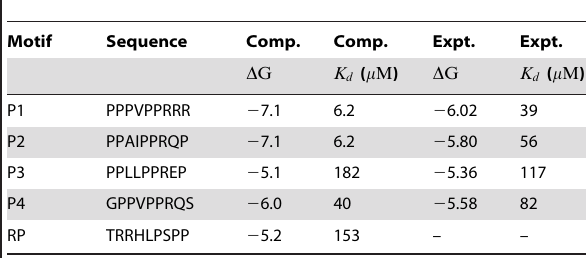
Table 1. Binding Energies of motifs to N-SH3 domain of Grb2.